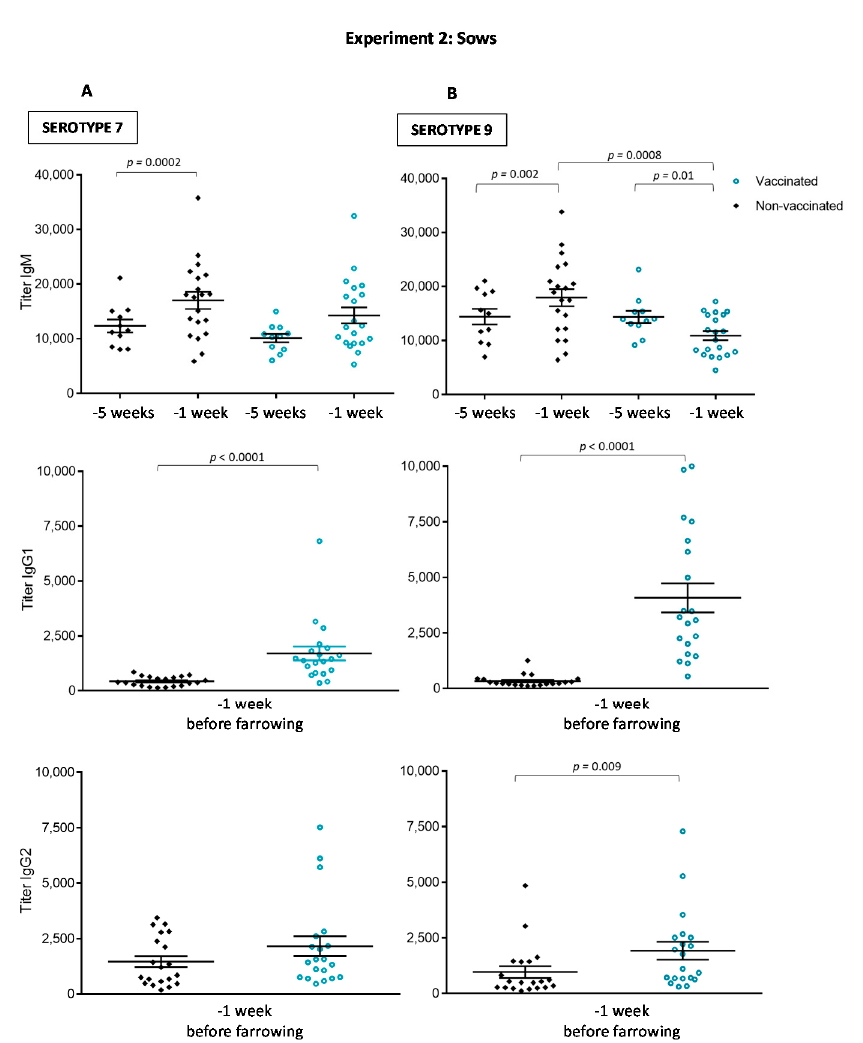
Figure 7. Experiment 2: Isotype profile of antibodies against S. suis serotype 7 ( A ) or serotype 9 ( B ) in sows. Blood samples were collected one and five weeks before farrowing from 20 vaccinated and 20 non-vaccinated sows to follow the immune response. The vaccination protocol is shown in Figure 1. IgM, IgG1 and IgG2 titers were determined by ELISA. Antibody titers for individual sows are shown with horizontal bars representing mean ± SEM. Values significantly different are shown in the graph with corresponding p value.